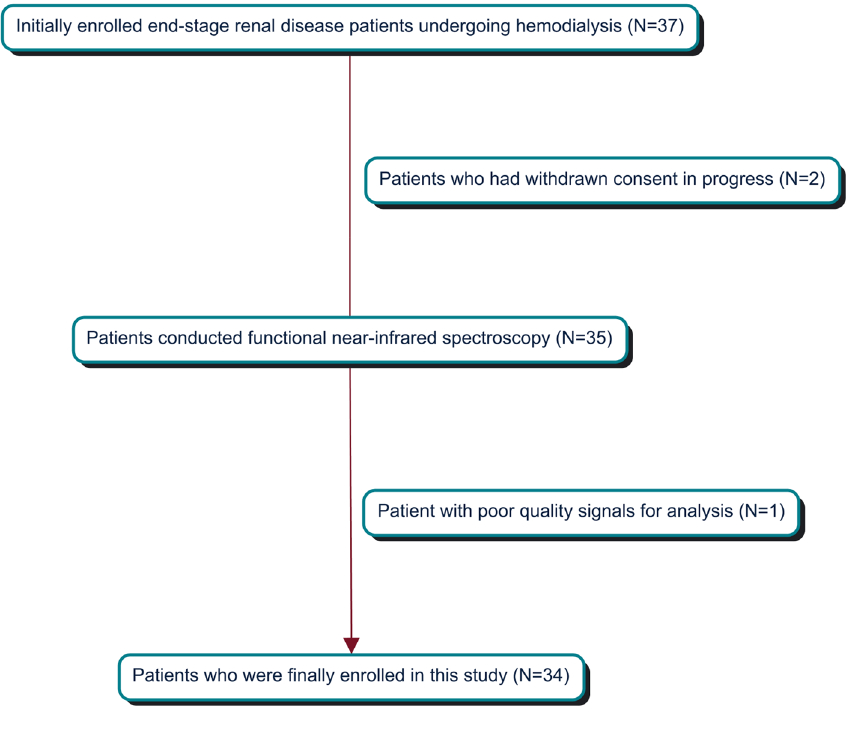
Figure 1. Patient selection